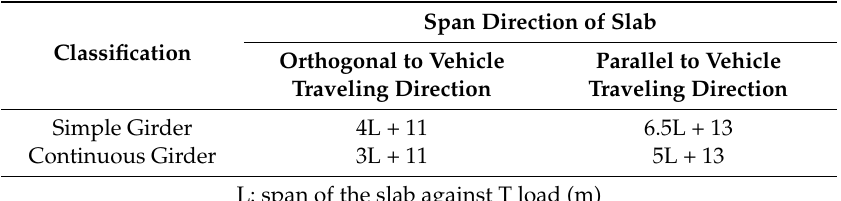
Table 8. Design specification of slab thickness for simple girder and continuous